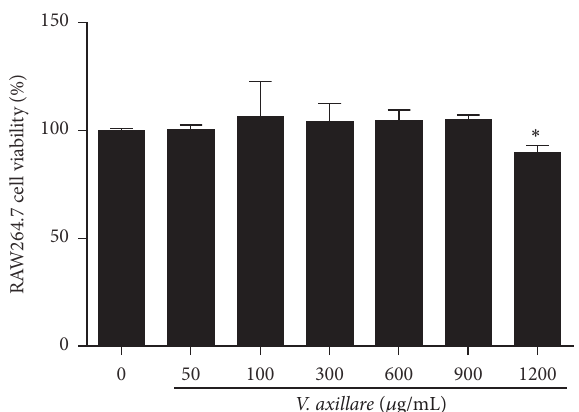
Figure 3: Effects of V. axillare on cell viability in RAW264.7 cells. Variousconcentrationsof V.axillare weretreatedtothecellsfor24 h, and the cell viability was measured by CCK-8 assay, as described in the Materials and Methods. The values represent the mean ± SD from three independent experiments ( ∗ 𝑝 < 0.05 indicates a significant difference versus untreated control cells by Student’s 𝑡 -